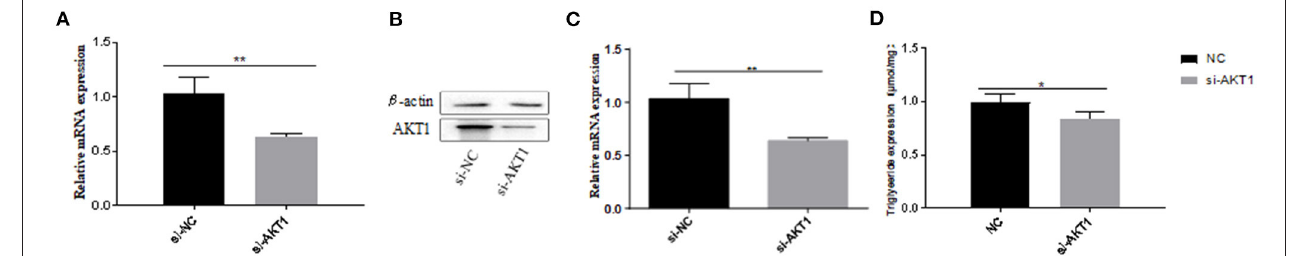
FIGURE 6 | Effects of AKT1 on the metabolism of adipocytes in Qinchuan cattle. (A) The efficiency of si-AKT1 transfection; (B,C) The expression levels of AKT1 mRNA and protein in pre-adipocytes transfected with si-AKT1 and negative control cells were compared; (D) After si-AKT1 treatment, the triglyceride level in pre-adipocytes decreased. Error bars represent mean ± SD. n = 3 replicates. *denotes significance according to Student’s t -test, * p < 0.05, ** p < 0.01, and *** p < 0.001.